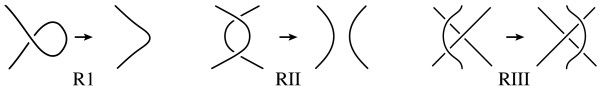
Reidemeister moves.